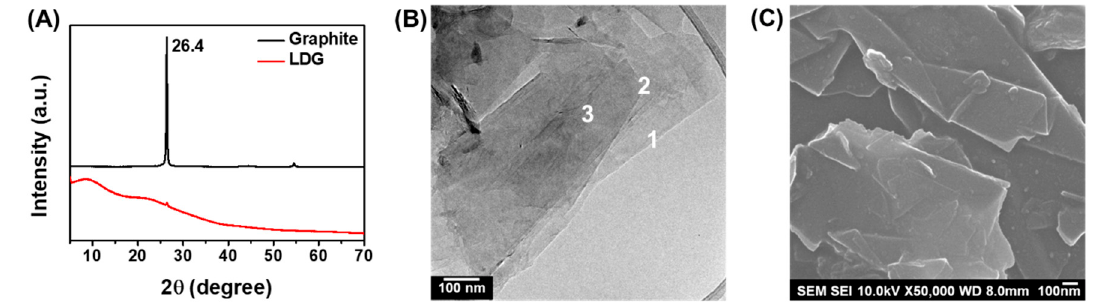
Figure 2. Characterization of LDG by ( A ) X-ray diffraction spectroscopy, ( B ) TEM, and ( C ) SEM.